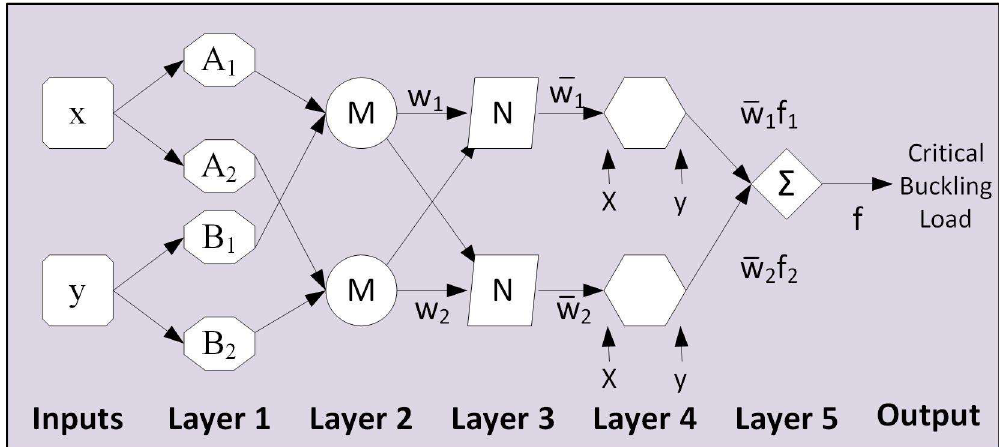
Figure 1. Architecture of the ANFIS technique with two inputs ( x and y ) and one output ( f ).